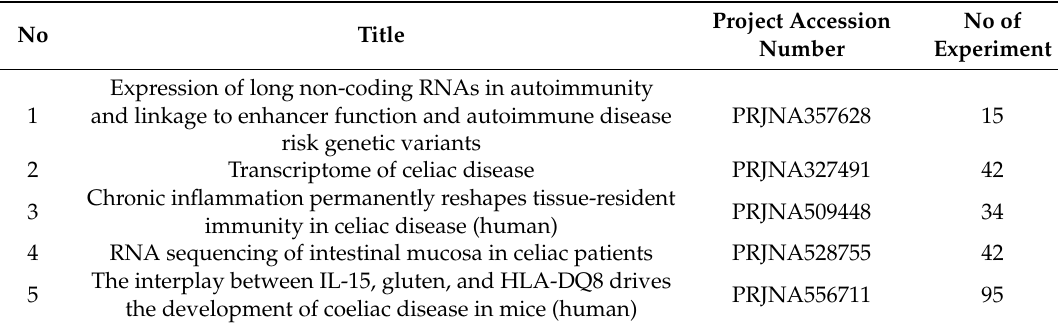
Table 1. Summary of the most relevant Sequence Read Archive (SRA) projects for celiac disease (CD).